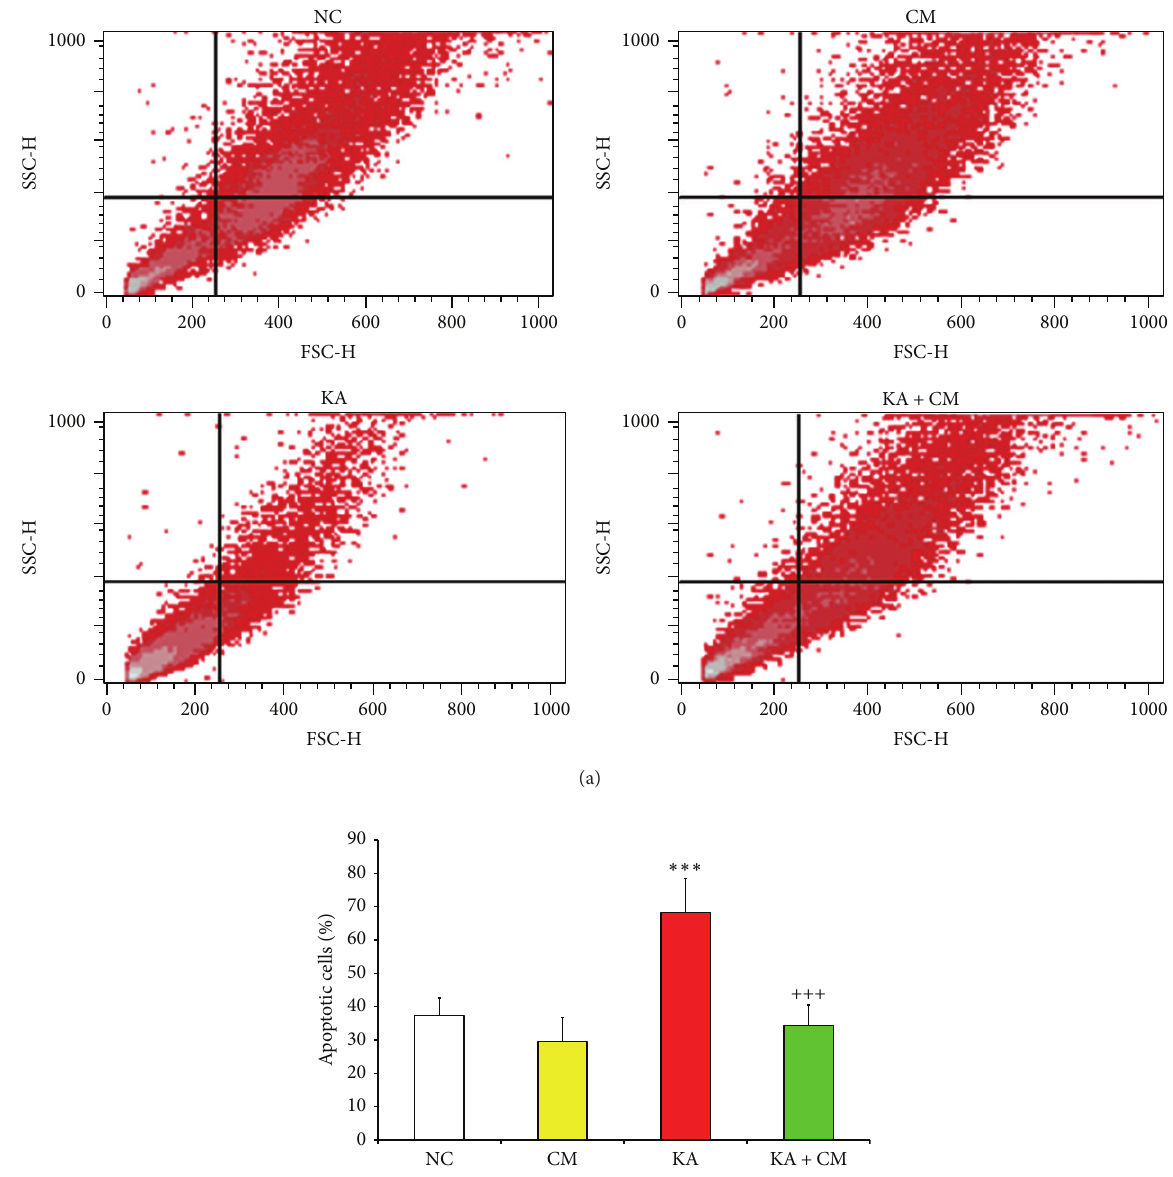
Figure 3: Antiapoptotic effect of HEK-CM. (a) Representative Flow cytometric Scatter Plots demonstrating the apoptotic and antiapoptotic effects of KA and HEK-CM, respectively. (b) Bar diagrams representing the percentage of apoptotic cells in various treatment groups. Normal control (NC), normal control exposed to HEK conditioned medium (CM), Kainic acid alone treated (KA), and Kainic acid and HEK conditioned medium cotreated (KA + CM). Data represented as mean ± SEM. ∗ indicates comparison between NC and treatment; + indicates comparison between KA lesion and treatment; ∗∗∗ 𝑃 < 0.001 ; +++ 𝑃 < 0.001